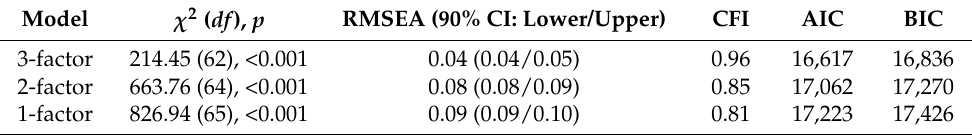
Table 1. Results of confirmatory factor analyses of the three mathematical scales at t3 ( n = 1350).